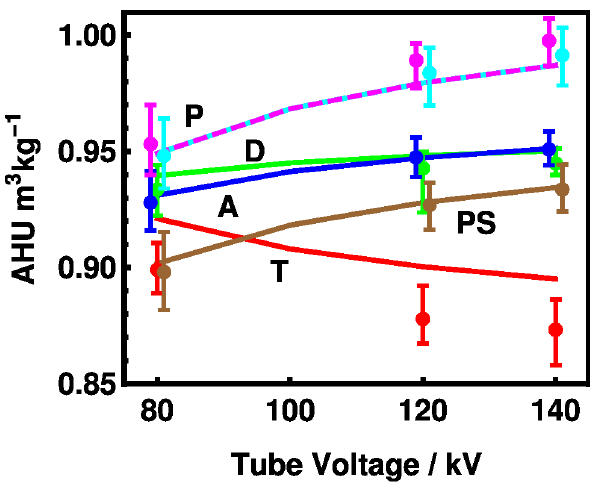
Fig 9. Mass HU potency vs. tube voltage for reference materials from the Catphan phantom. [31] The materials are T (Teflon, or polytetrafluoroethylene C 2 F 4 , red), D (Delrin, CH 2 O, green), A (acrylic, see Fig 8, blue), PS (polystyrene, C 8 H 8 , brown), and P (both low density polyethylene C 2 H 4 magenta, dashed and polymethylpentene C 6 H 12 cyan, overwritten) The tube voltages have been offset for clarity by -1 kV for and low density polyethylene and acrylic and by +1 kV for polymethylpentene and polystyrene. Conversions from the reported HU values are scaled by the densities 2160, 1415, 1180, 1040, 925, and 833 kg/m 3 , respectively. The error bars represent the minimum and maximum values as reported by [31] for 8 scanners, scaled by the